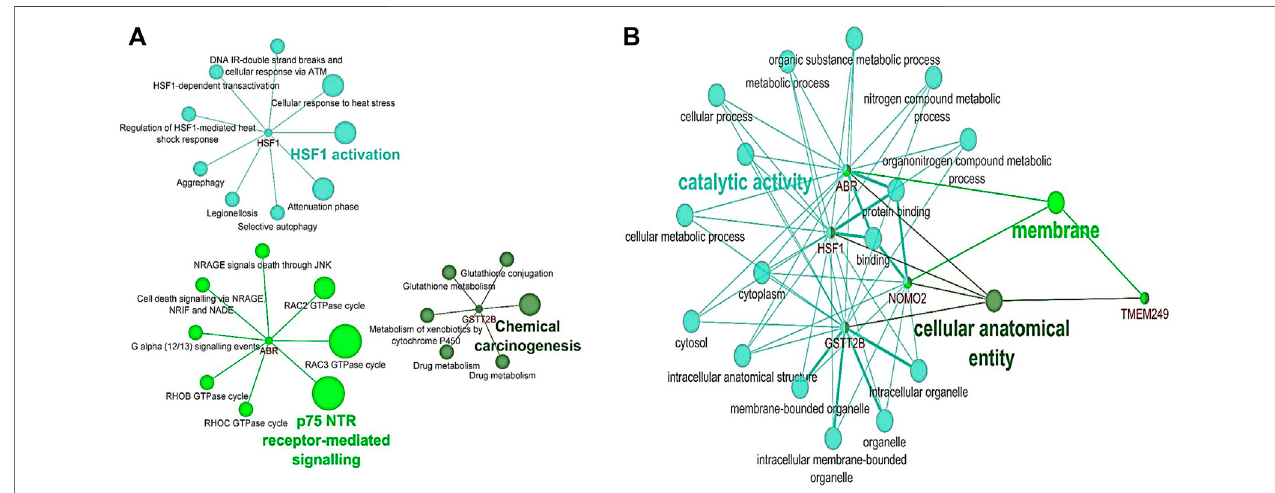
FIGURE 3 | Pathway and Gene Ontology analysis for six genes detected in NAC-resistant patients using the ClueGO plugin in Cytoscape. (A) Pathway analysis based on KEGG, Reactome, and WikiPathways. (B) Common results of GO analysis for HSF1, ABR, and GSTT2B according to biological processes and molecular